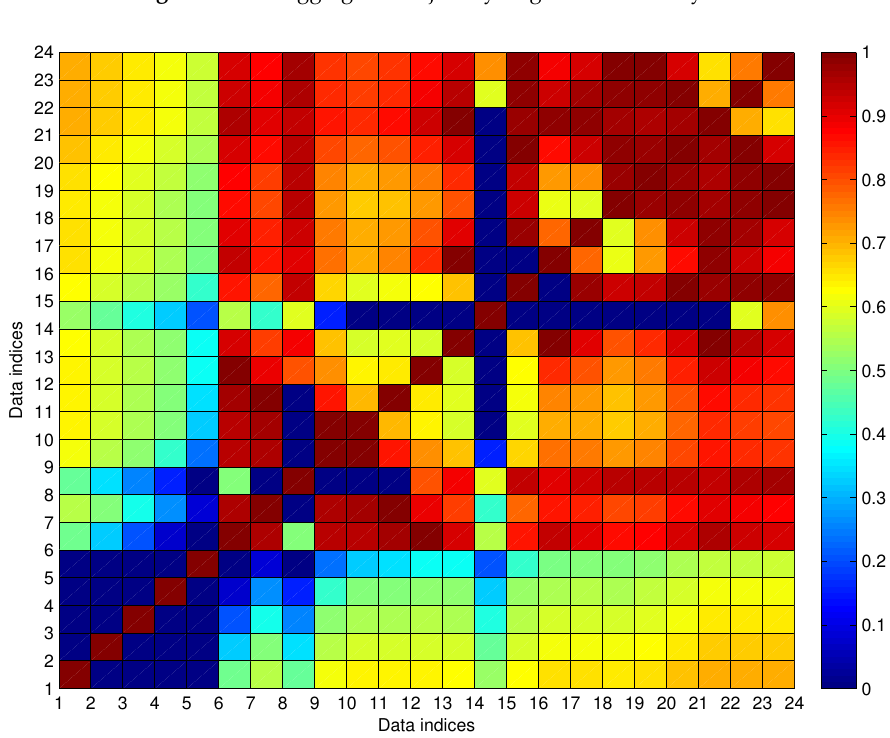
Figure 14. The evaluated fuzzy connecting membership function (MF) matrix for the trajectory fragment shown in Figure